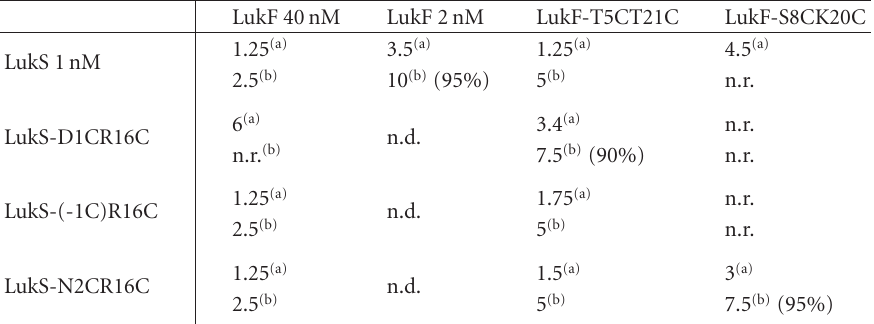
Table 1: Times (min) to reach (a) 5% and (b) 100% of the Fluo-3 fluorescence characteristic of the cellular entry of Ca 2+ due to calcium channels activation by combinations of PVL (taken as reference) and its mutants, n.r.: not reached, n.d.: not determined.